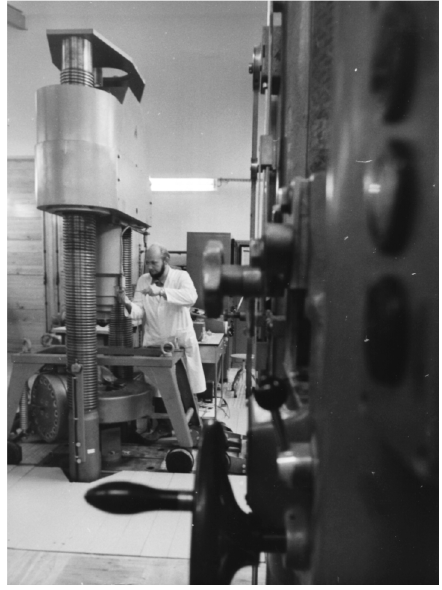
Figure 5. 600 t press with triaxial device.